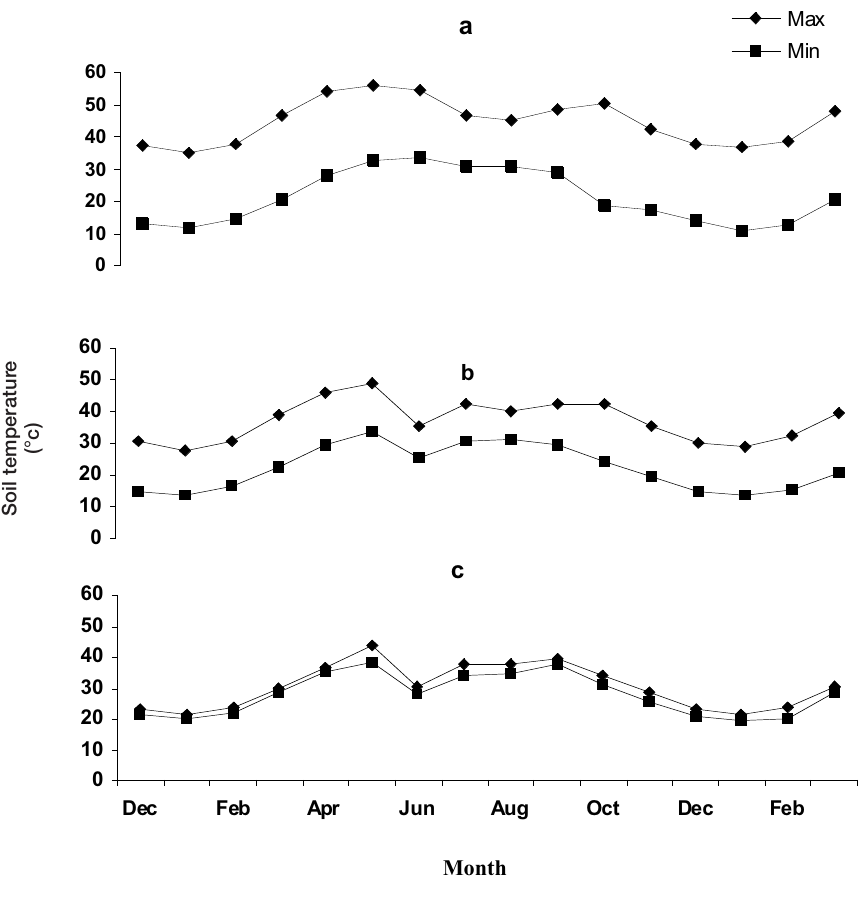
Fig. 1. Soil temperatures recorded during the test period at soil depths of 5 cm (a), 15 cm (b) and 25 cm